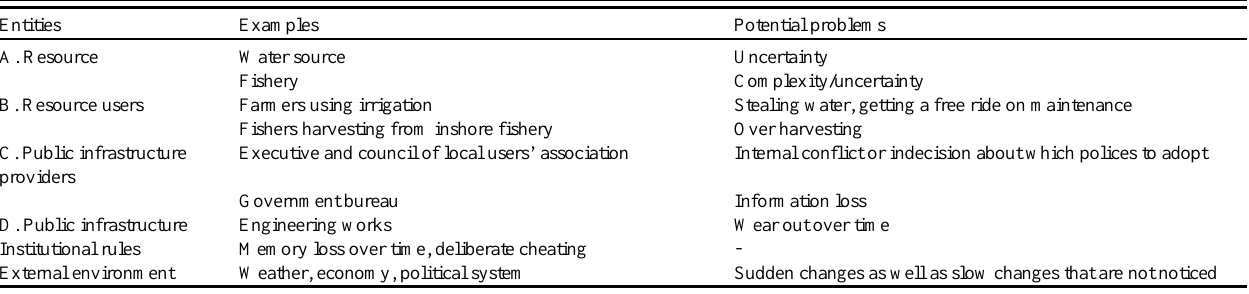
Table 2 . Entities involved in social-ecological systems together with examples and potential problems as identified by Anderies et al.